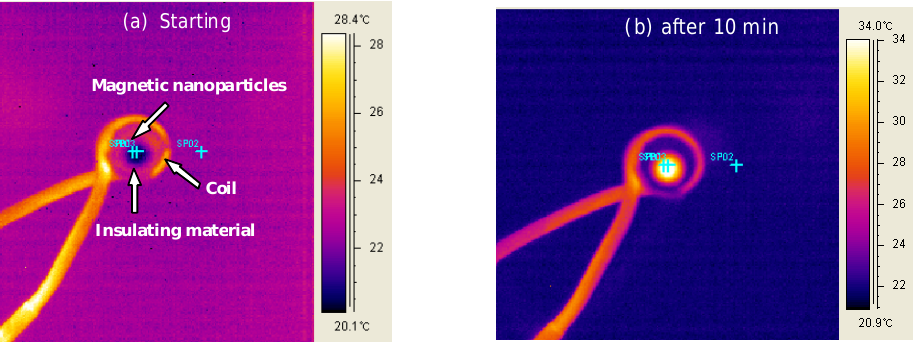
Figure 7. FLIR Thermacam ® images taken (a) at starting and (b) after 10 minutes for the heating of magnetic nanoparticles under a 653 Oe (266KHz)